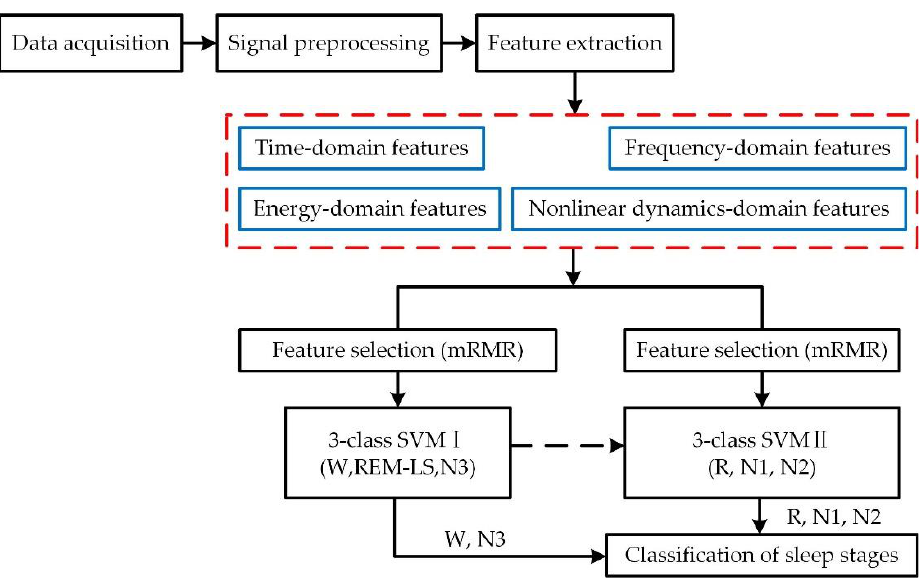
Figure 1. The sleep stage classification processing flow adopted in this paper.